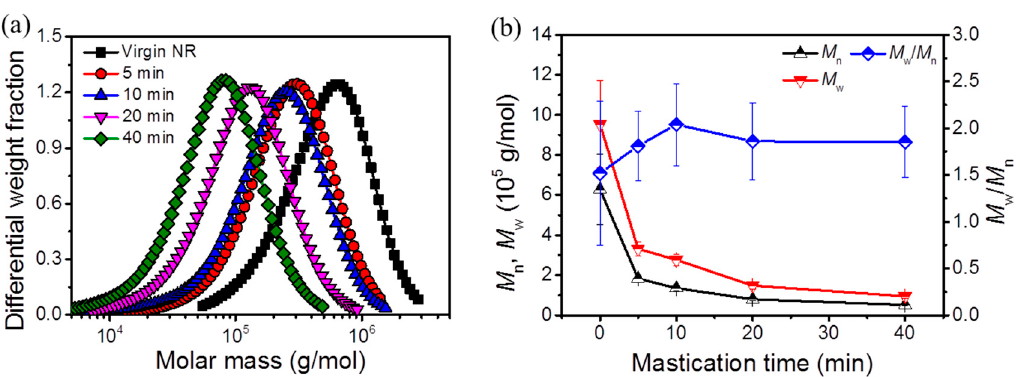
Figure 1. The molecular mass of masticated natural rubber (NR) with different mixing time: ( a ) Molecular mass distribution; ( b ) the number ( M n ), mass average molecular mass ( M w ) and the dispersity ( M w / M n ).